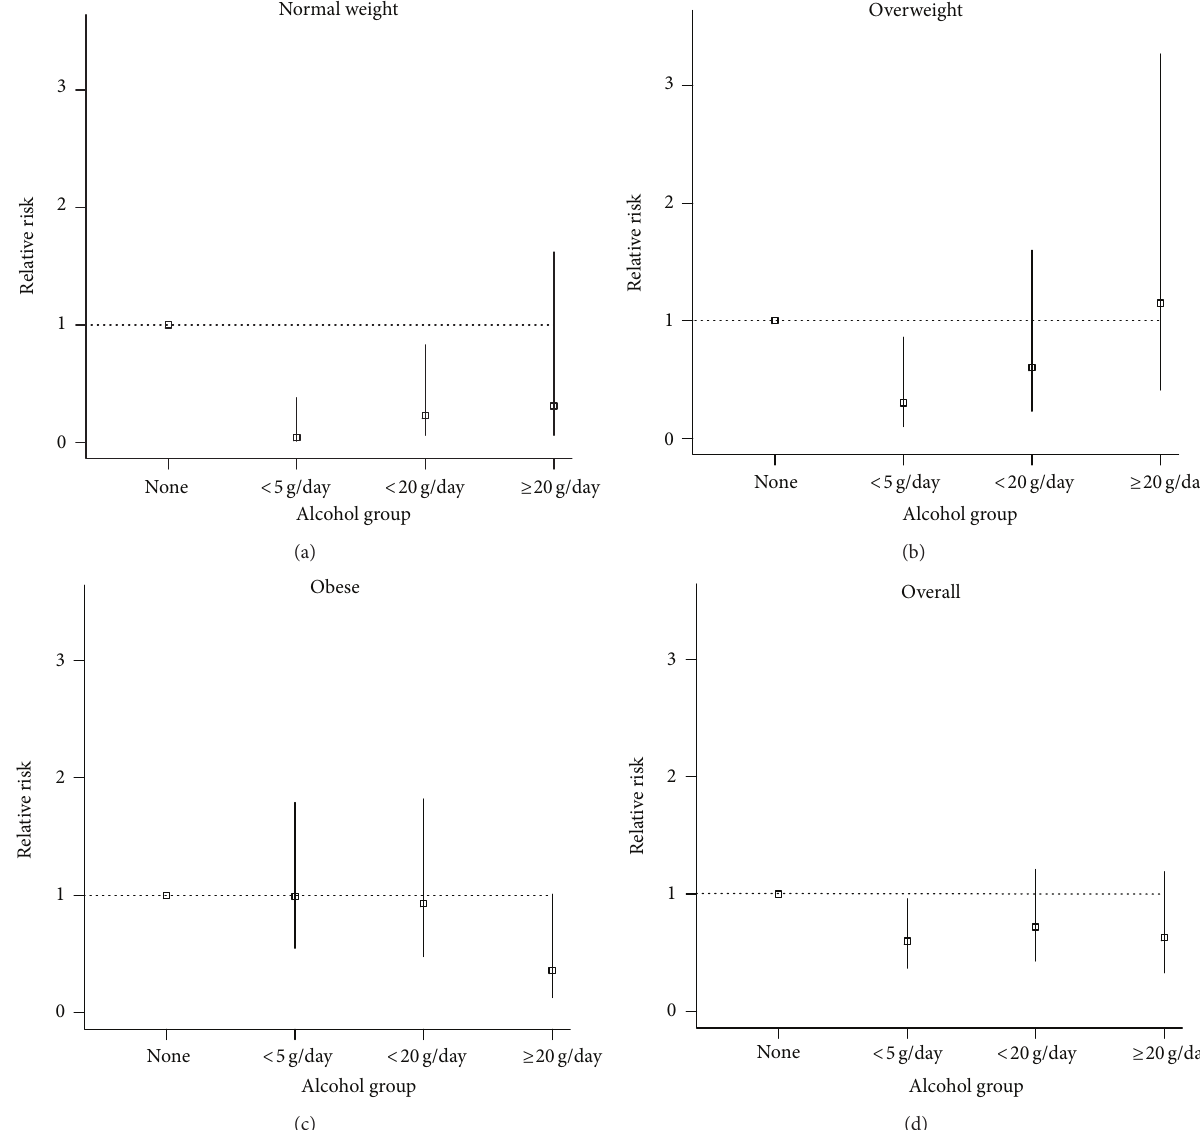
Figure 1: Relative risks and 95% confidence intervals for normal, overweight, and obese adults and overall by alcohol